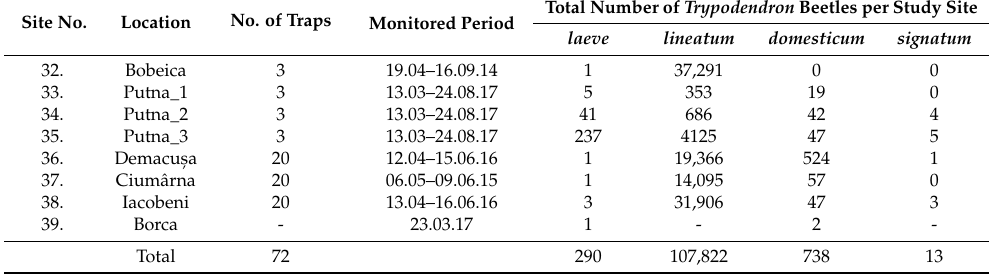
Table 3. Captures of Trypodendron species in other studies that have been conducted with synthetic pheromone of T.